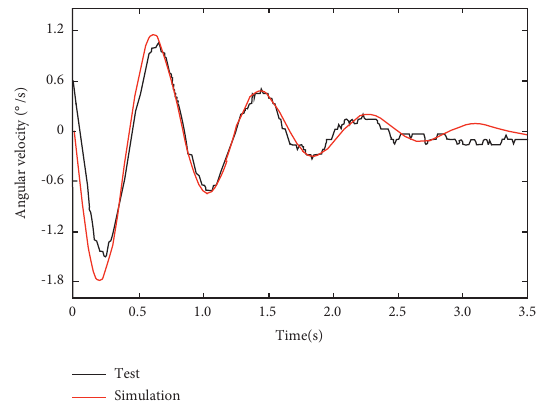
Figure 10: Comparison of roll angular